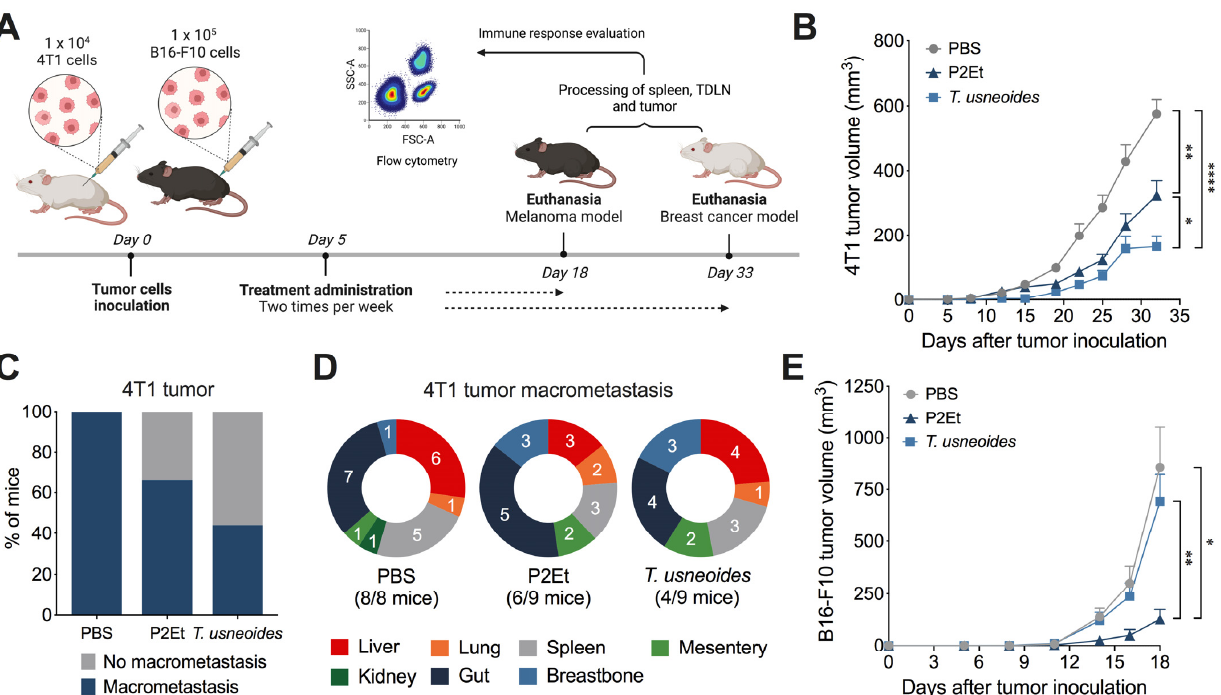
Figure 3. In vivo T. usneoides treatment delays breast tumor growth. ( A ). Experimental design to evaluate the antitumor effect of T. usneoides extract in BALB/c or C57BL/6 mice bearing 4T1 or B16 ‐ F10 tumors, respectively. Tumor was established by injection of 4T1 or B16 ‐ F10 cells; then,5 days after tumor cell injection, treatments were administrated two times per week until the end of the experiment. ( B ). Tumor volume in 4T1 tumor ‐ bearing mice treated with each treatment. ( C ). Bars showing the percentage of mice that developed macrometastasis in 4T1 breast cancer model. ( D ). Distribution of multi ‐ organ metastasis of 4T1 tumors for all groups. ( E ). Tumor volume in B16 ‐ F10 tumor ‐ bearing mice treated with each treatment. The numbers on the pies show the mice with macrometastasis and numbers in parenthesis correspond to the total number of mice with metastases. The p values were calculated using Kruskal–Wallis and Dunn’s post test for multiple comparisons.